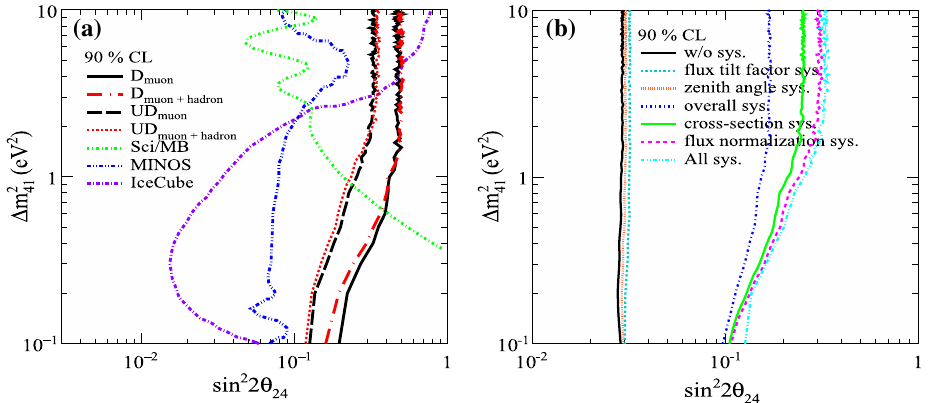
− sin 2 2 θ Fig. 6 a The 90% C.L. exclusion limits in the (cid:2) m 2 sterile mixing angles are taken as θ 14 = θ 34 = 0.0 ◦ . The 90% C.L. 24 plane, 41 ( 1 − U μ ) 2 ,expectedfrom 1Mt-yr oftheICAL SciBooNE/MiniBooNE, MINOS and IceCube exclusion regions are where sin 2 2 θ 24 = 4 U 2 μ 4 4 shown for comparison, b impact of individual systematic uncertainty data. The symbols ‘D’ and ‘UD’ correspond to only downward-going on the sensitive neutrinos and neutrinos from all directions. Here, the other active–